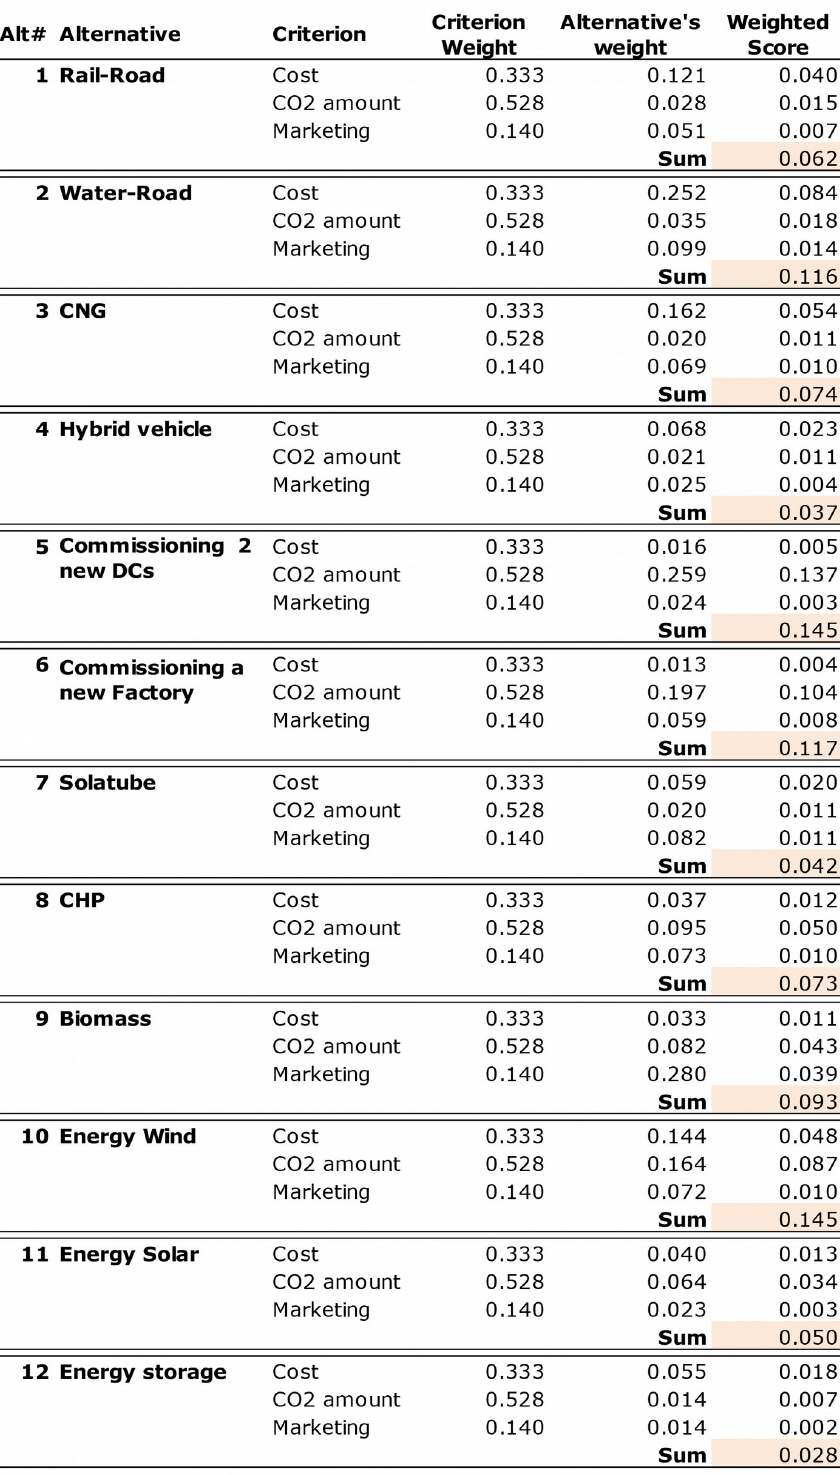
Figure 6. Final priorities AHP technique for the case